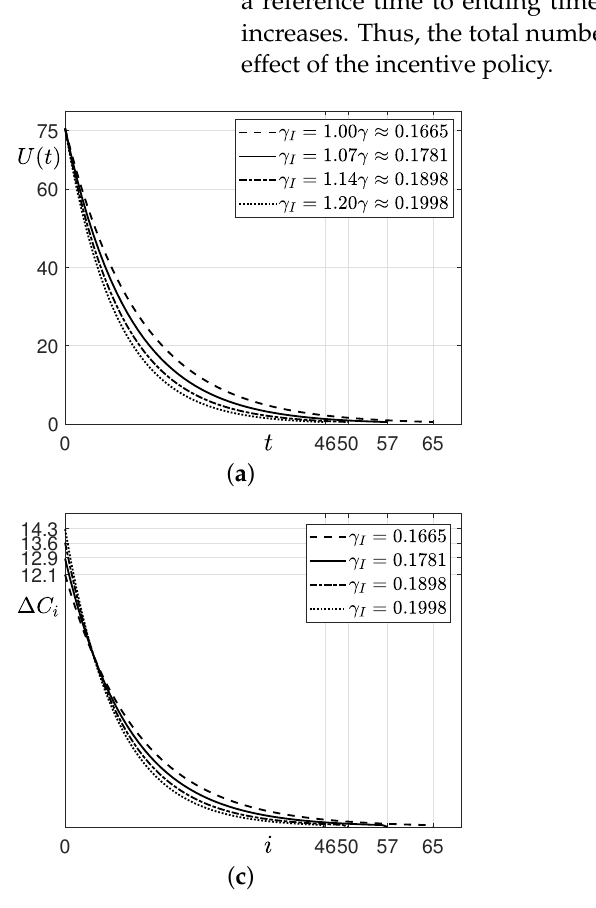
Figure 5. Computational results of ( a ) U ( t ) , ( b ) T , ( c ) ∆ C i , and ( d ) ∆ C with respect to γ I .